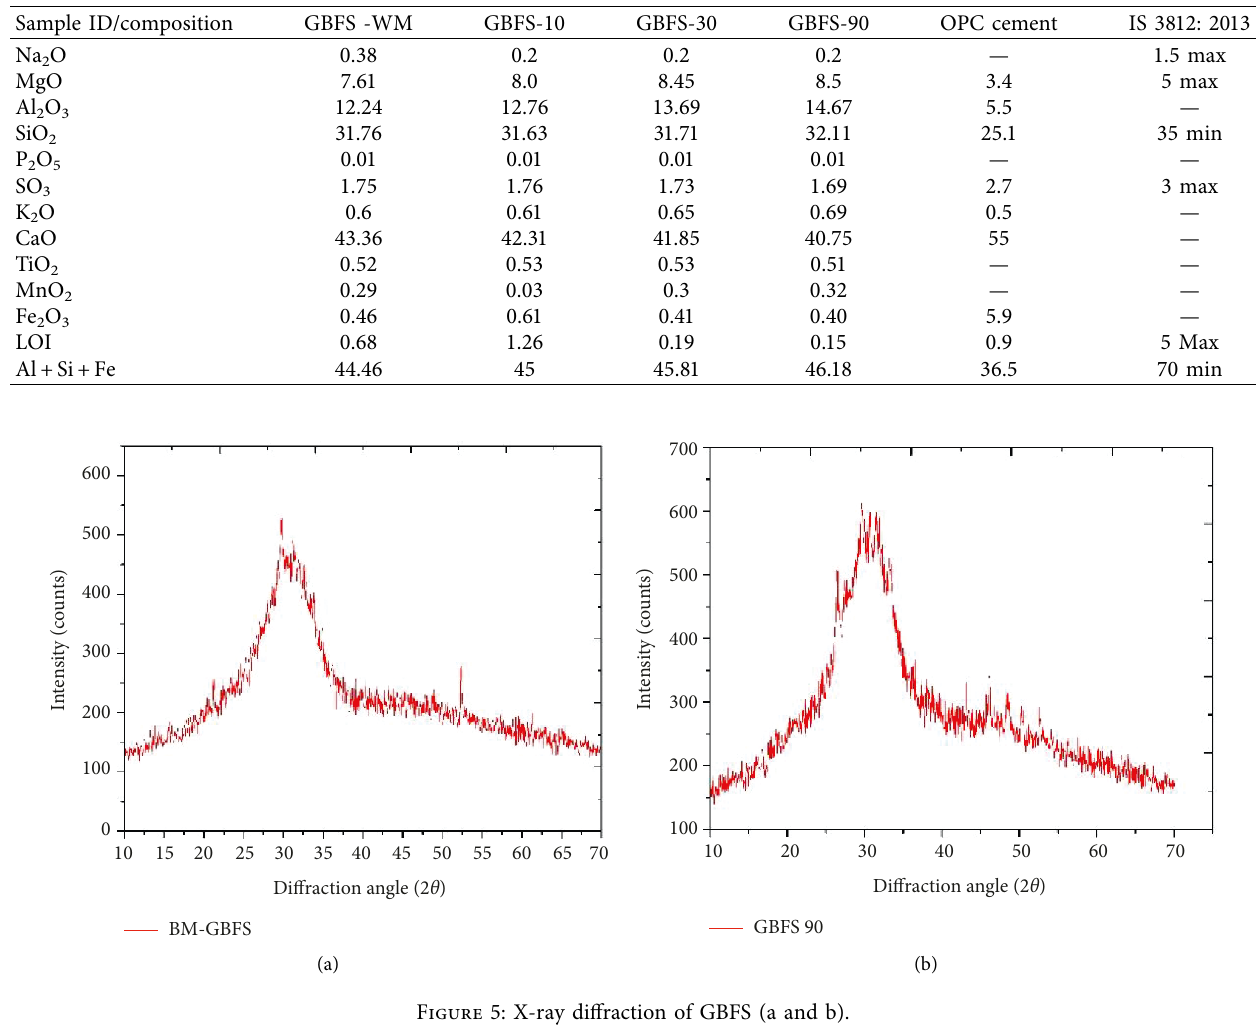
Table 4: XRF analysis of before and after milled samples.